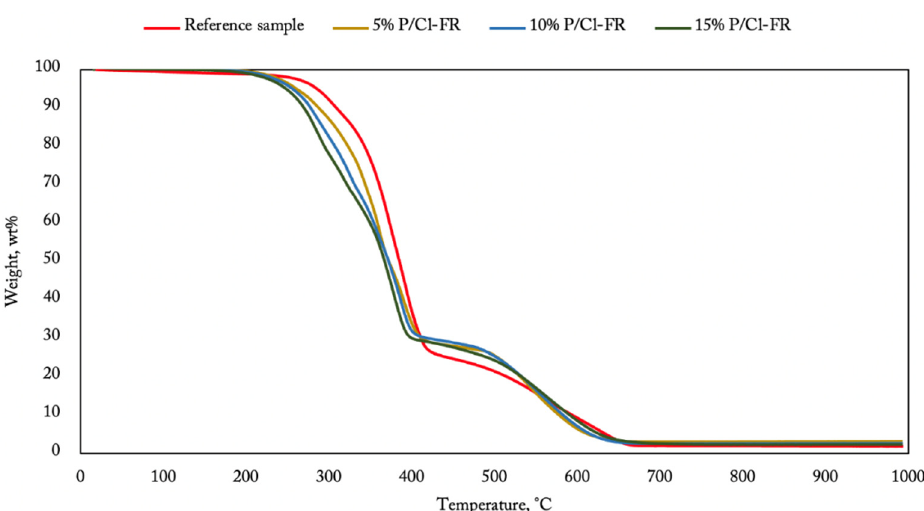
Figure 8. TGA of polyurea–polyurethane coatings containing RDP.